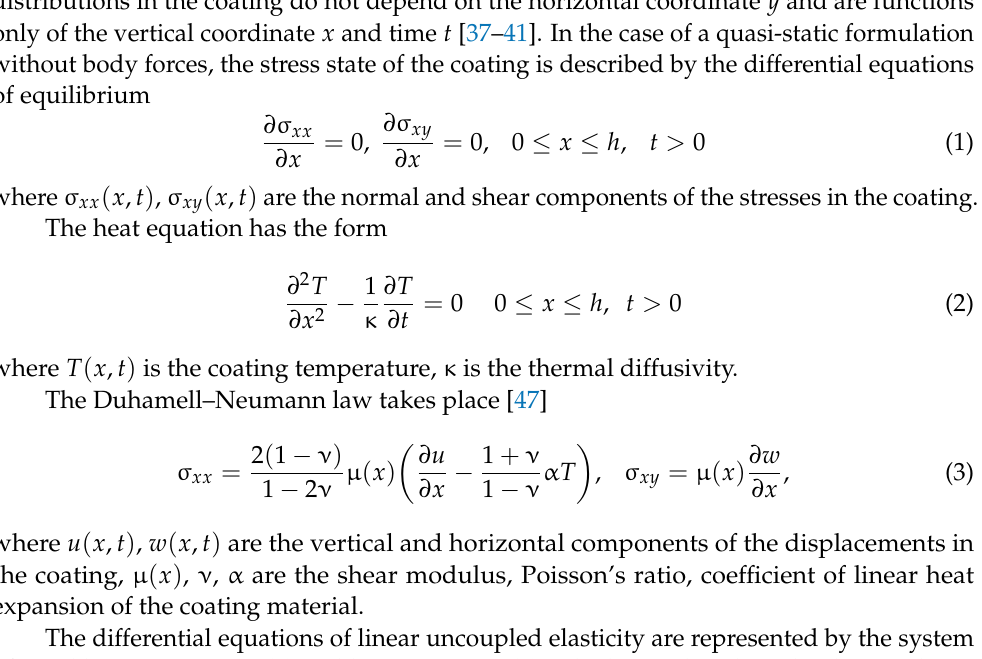
where T ( x , t ) is the coating temperature, κ is the thermal diffusivity.